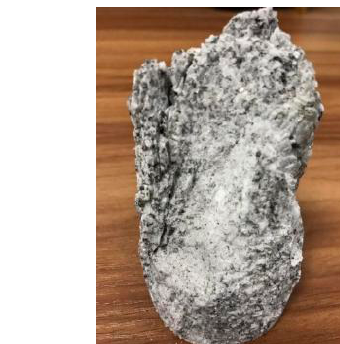
Figure 8. The fitting curve using Hoek–Brown strength criterion.